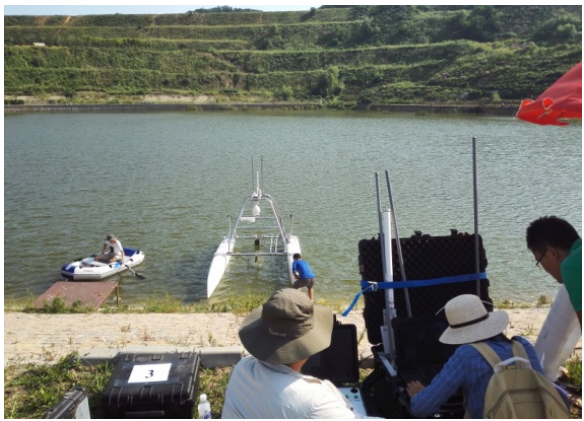
Figure 5. The ‘JiuHang 490’ USV’s lake trial in